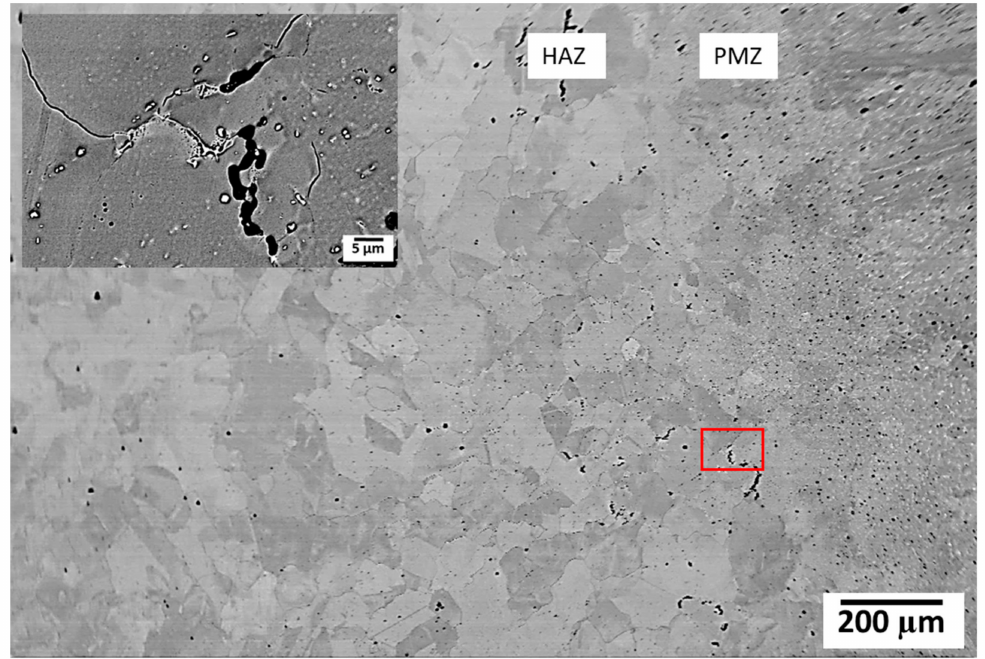
Figure 12. Liquation at grain boundaries causing cracking in HAZ of SLM-manufactured and HIP Alloy 718; inset showing the marked